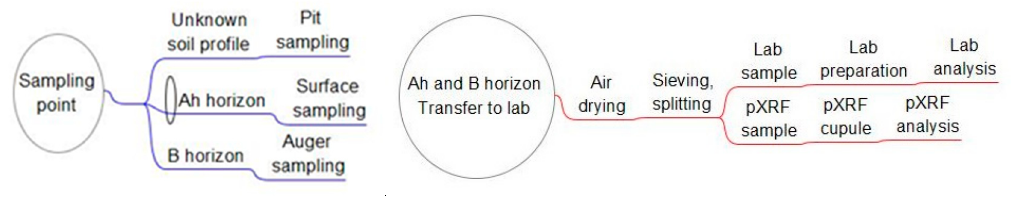
Figure 3. Flow chart showing sample collection and sample preparation.